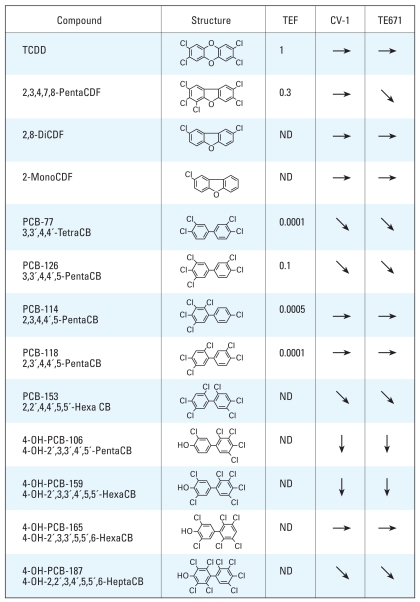
Effects of PCBs/dioxins on TR-mediated transcription in the presence of T3 (10−7 M) in CV-1 and TE671 cells. Down arrows indicate suppression > 50% at 10−8 M PCBs/dioxins; diagonal arrows indicate mild suppression (significant, but < 50% at 10−8 M); and right arrows represent no effect. TEF = 1 for the most toxic congener, TCDD. Congeners without TEF are indicated as ND (Van den Berg et al. 2006).